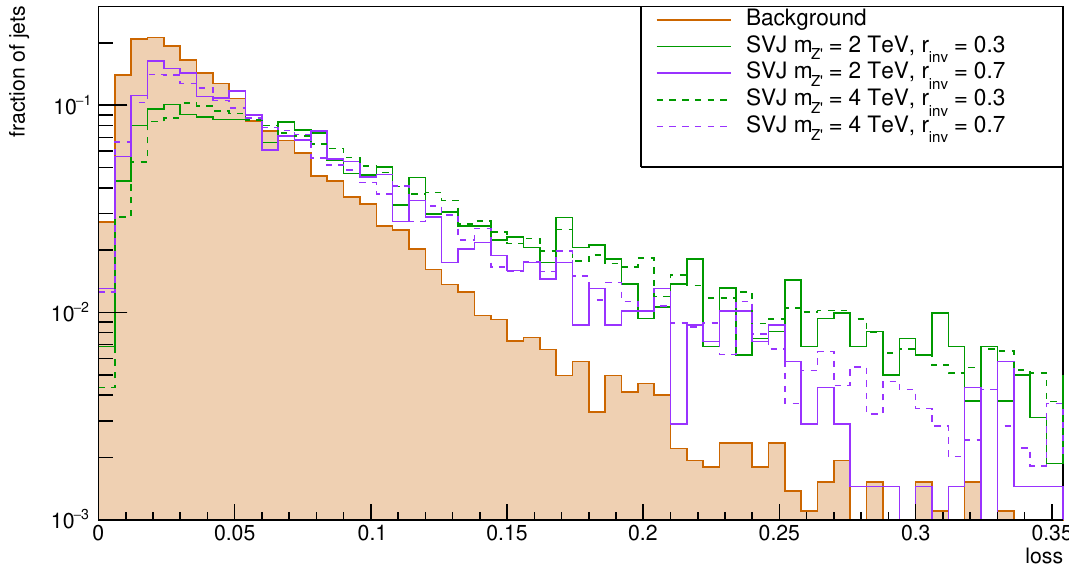
Figure 4. Reconstruction loss for QCD and different SVJ